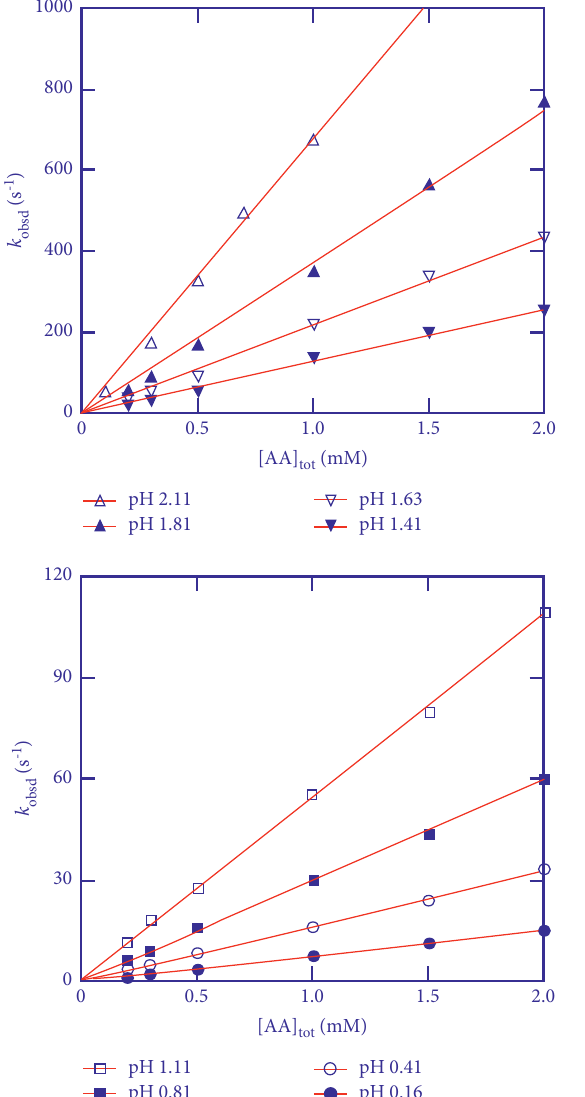
Figure 2: Dependencies of k ionic strength for reduction of [IrCl 6 ] 2– by AA.